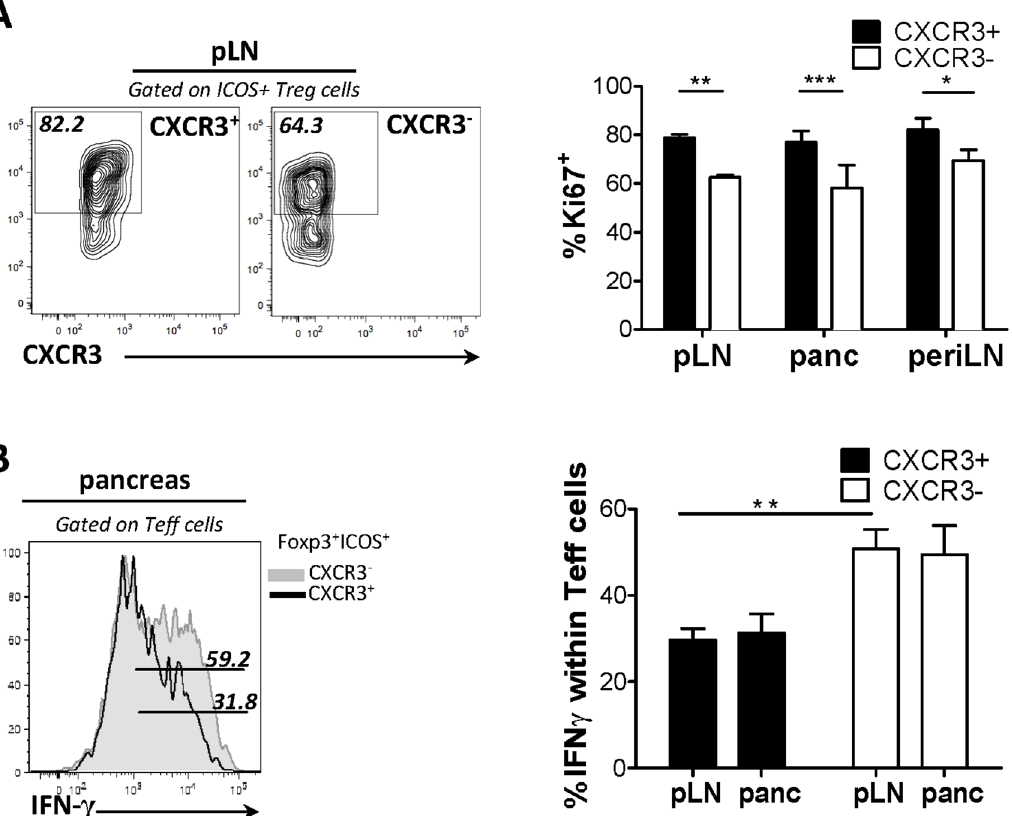
Fig 2. CXCR3 expression delineates a functionally fit subpopulation of ICOS + T reg cells. (A) Cell suspensions of pancreatic draining LN from 4-week- old mice were isolated and percent cycle cells, determined by Ki-67 expression, were compared between the CXCR3 + and CXCR3 - subsets of ICOS + T reg cells. (B) NOD.TCR α -/- mice received T eff (7.5X10 5 ) cells and either CXCR3 + or CXCR3 - ICOS + T reg cells (7.5X10 4 ) cells isolated from pooled LN and spleen of BDC2.5 mice. After 14 days suppression was assessed via percent IFN- γ + cells among T eff cells in the pancreas and draining LN. (n = 4).